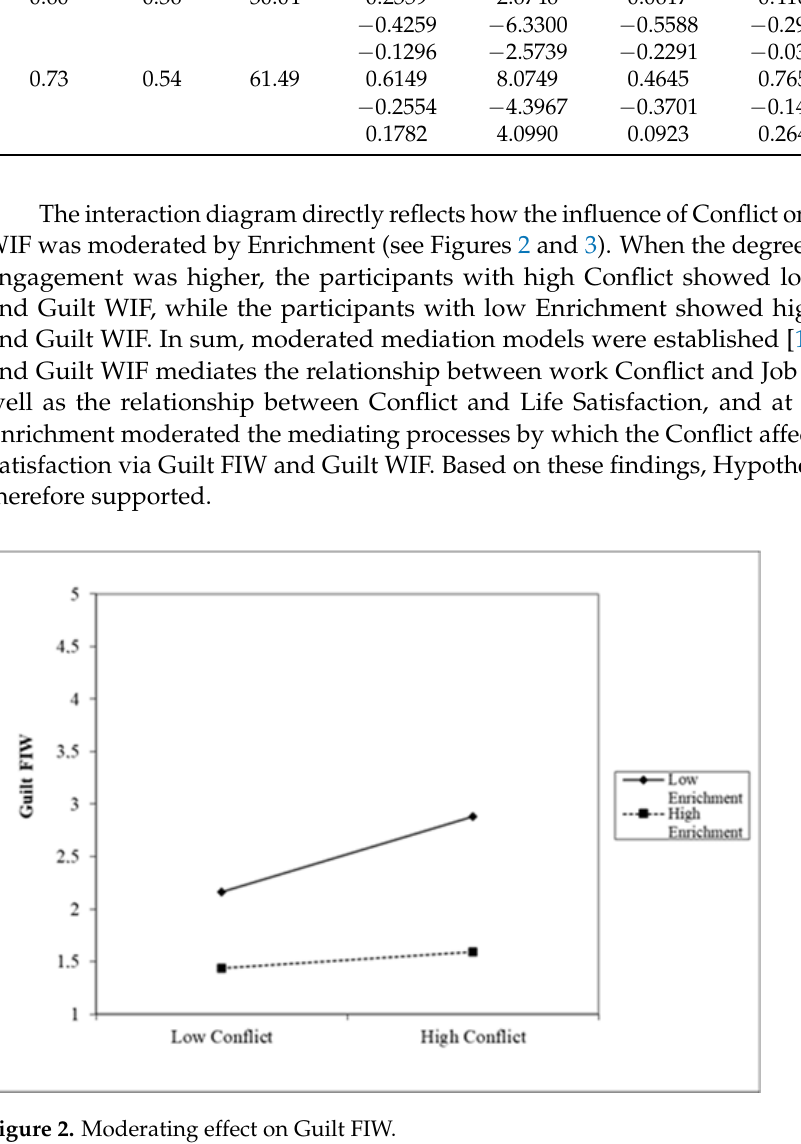
Figure 3. Moderating effect on Guilt WIF 4. Discussion This study aimed to analyse, first, two mediation models where Guilt FIW and Guilt WIF mediate the relationship between work Conflict and Job Satisfaction (Hypothesis 1), and the relationship between Conflict and Life Satisfaction (Hypothesis 2). Secondly we develop two models where higher levels of Enrichment are able to buffer these mediating processes by reducing the effects of Conflict on Job Satisfaction (Hypothesis 3) and Life Satisfaction (Hypothesis 4) via Guilt FIW and Guilt WIF. The results obtained allowed us to confirm all our Hypotheses. Indeed, Guilt FIW and Guilt WIF mediate the relationship between Conflict and Job Satisfaction, as well the relationship between Conflict and Life Satisfaction. Enrichment is able to moderate these mediating